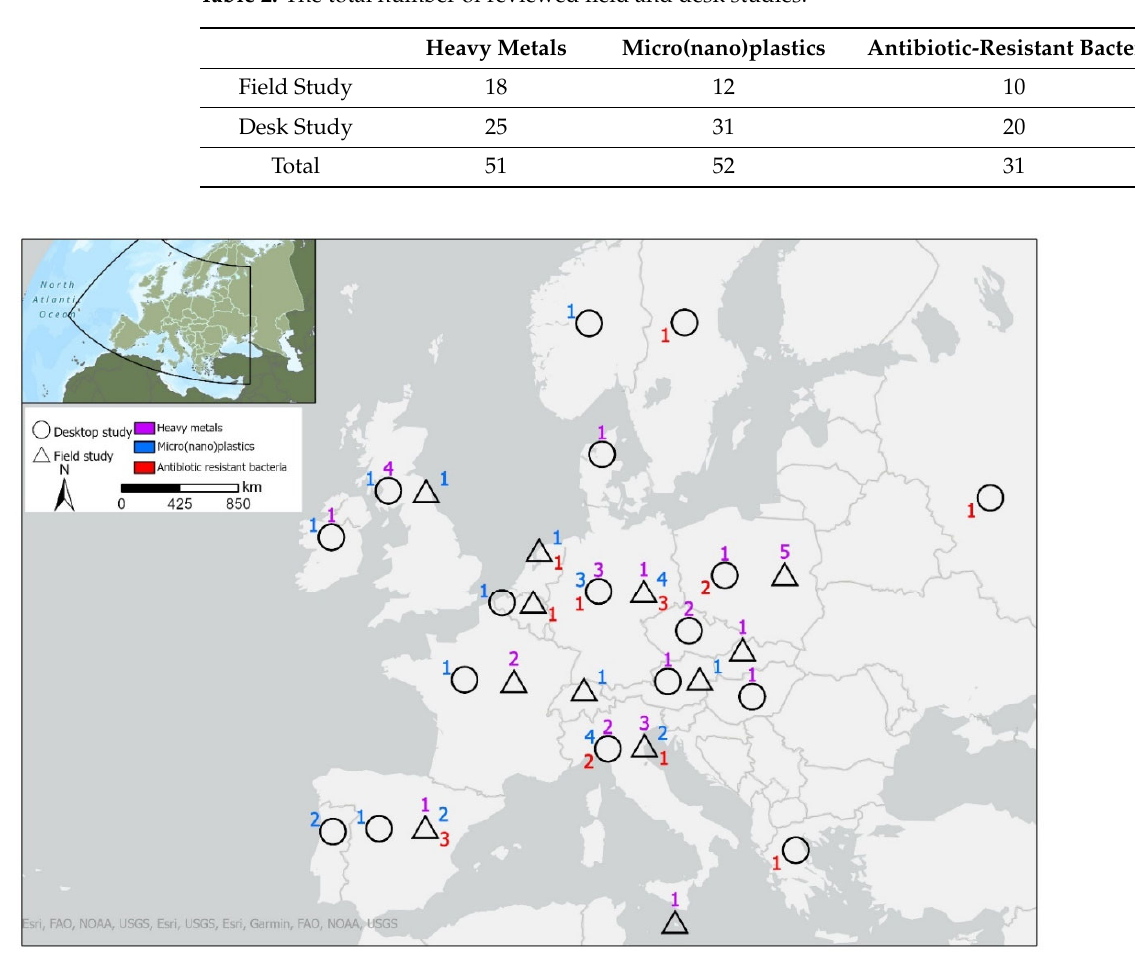
Figure 1. Europe: Number of studies on heavy metals, micro(nano)plastics, and antibiotic-resistant bacteria considered in our review, per country. Field studies were counted for the country where the analysis was performed, desk studies were counted for the country of the first author’s institution. The vast majority of the studies—90% of HMs, 96% of MNPs, and 93% of ARB